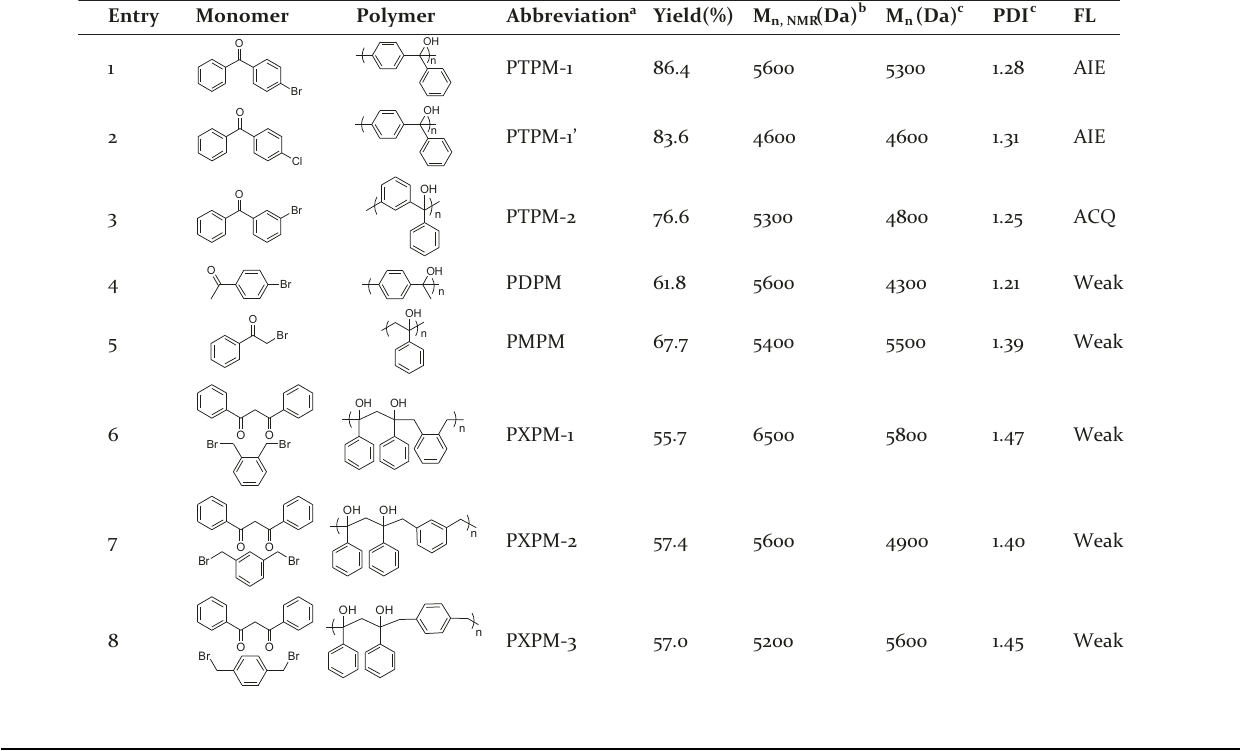
Table 1 The monomer structures and results of polymers synthesized via Barbier polyaddition in THF at 80 °C for 24 h Entry